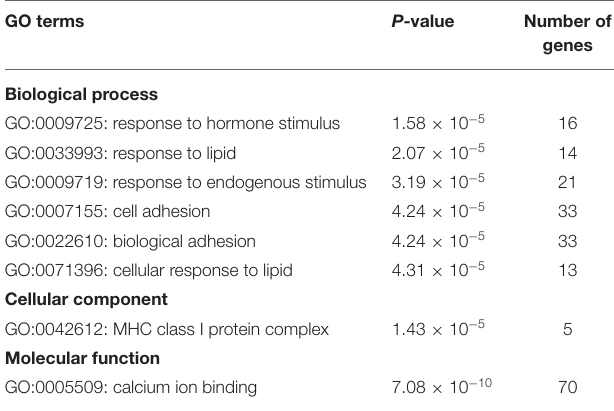
TABLE 2 | Biological process enriched by the differentially expressed mRNAs in M120 vs. M90